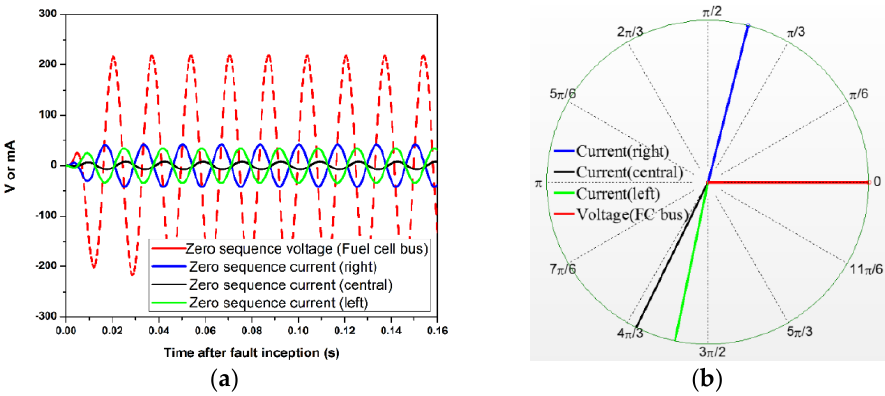
Figure 18. The zero-sequence voltage and current at the switchboard 4 (SWB4) in the case of a microgrid network high impedance fault in grid-connected mode: ( a ) Zero-sequence voltage and current; ( b ) Phase relation.